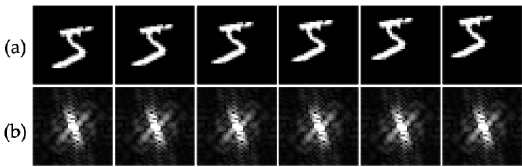
Figure 2. Spatial images and their corresponding frequency images. ( a ) spatial images of a zero-pixel shift to 5-pixel shifts from the center, ( b ) their corresponding frequency images having the same appearance.